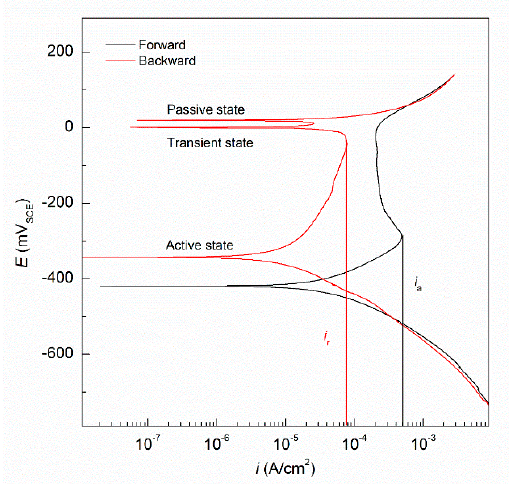
Figure 2. DL − EPR (double loop electrochemical potentiokinetic reactivation) plot for Inconel 718 annealed at 675 °C for 2 h, sample I1.